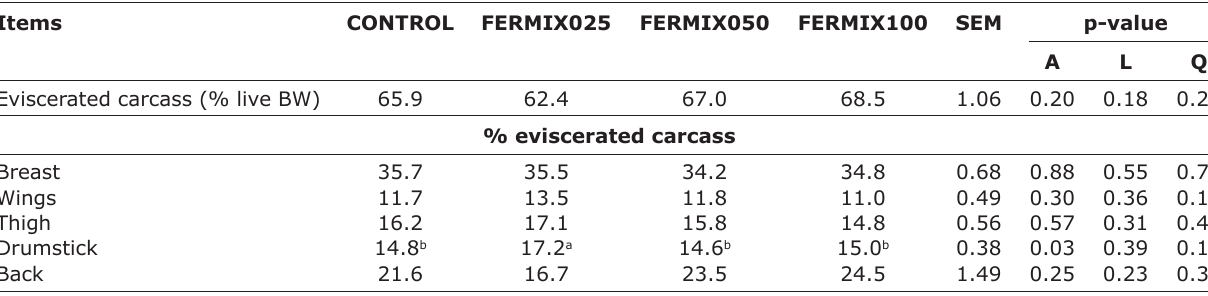
Table-4: Carcass traits of broiler chickens. Items